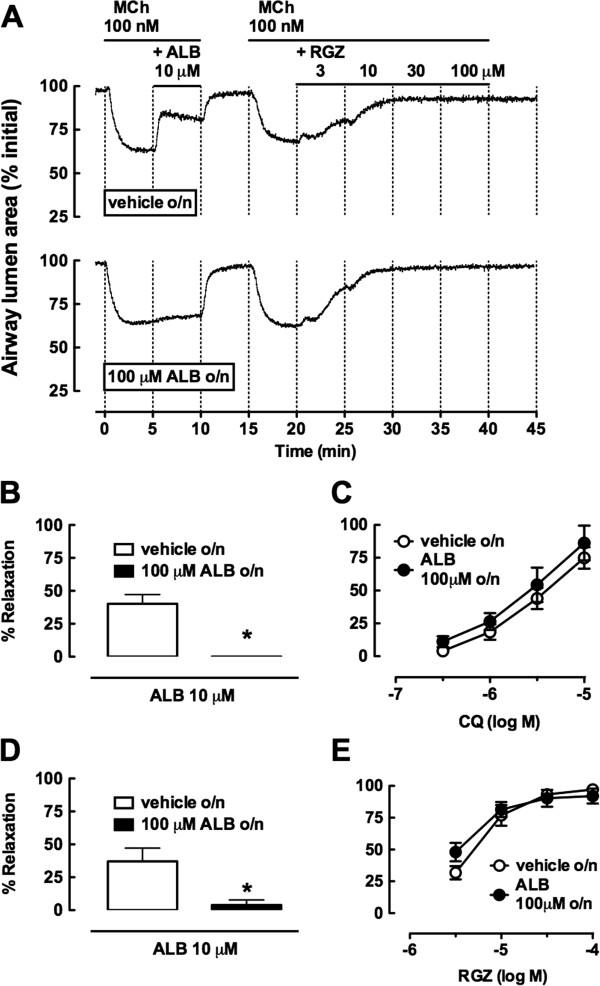
Rosiglitazone and chloroquine maintain potency and efficacy despite β-adrenoceptor desensitization. Slices were incubated overnight with vehicle (0.1% water) or albuterol (ALB, 100 μM). Airways were then pre-contracted with 100 nM methacholine (MCh) prior to addition of 10 μM ALB and concentration response curves to rosiglitazone (RGZ) or chloroquine (CQ). A) Representative traces illustrating RGZ concentration-response curves following overnight incubation with vehicle or ALB. Relaxation responses to B) C) 10 μM ALB and CQ (n = 4/group) and D) E) 10 μM ALB and RGZ (n = 4/group) following overnight incubation with vehicle or 100 μM ALB. *p < 0.05, unpaired t-test.